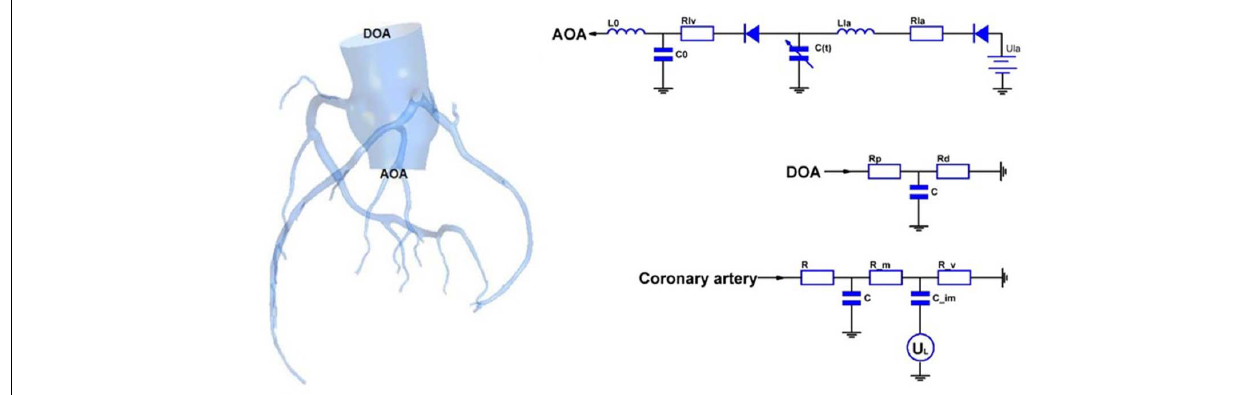
FIGURE 1 | Geometric multi-scale model of normal coronary arteries.